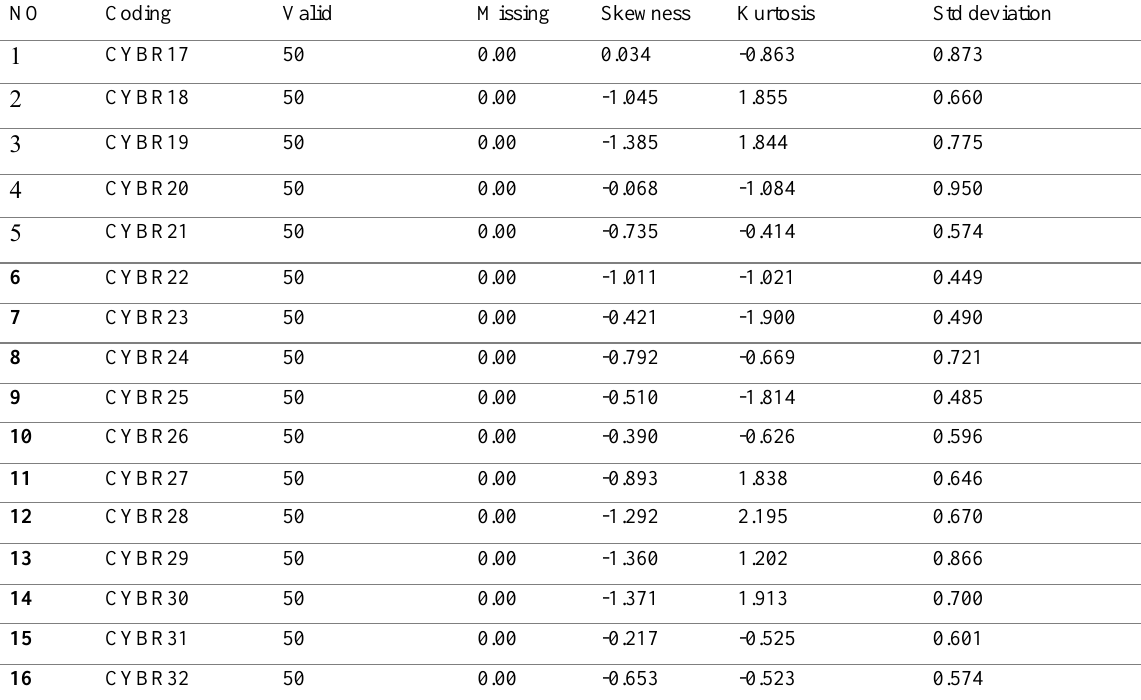
Table2: The results of the normal distribution of the Cybersecurity